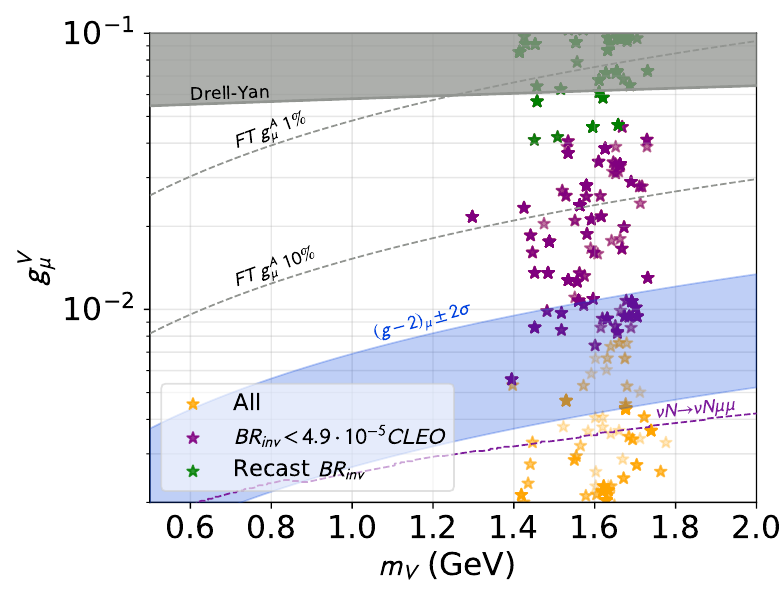
Figure 6 . Results of the scan in the low m V region. The colour code is the same as in (cid:12)gure 4. the solutions also marked in green in (cid:12)gure 4, which provide a satisfying (cid:12)t to the (cid:13)avour observables and escape B ! K +inv. limits when this channel is open. Yellow points show the corresponding case with only (cid:31) in the spectrum, which are subject predominantly to 1 the bound from B ! K (cid:3) (cid:22)(cid:22) . The parameter space is partially tilted towards the small width for the green points, since the channel B ! K + inv. is open and constrains the larger invisible